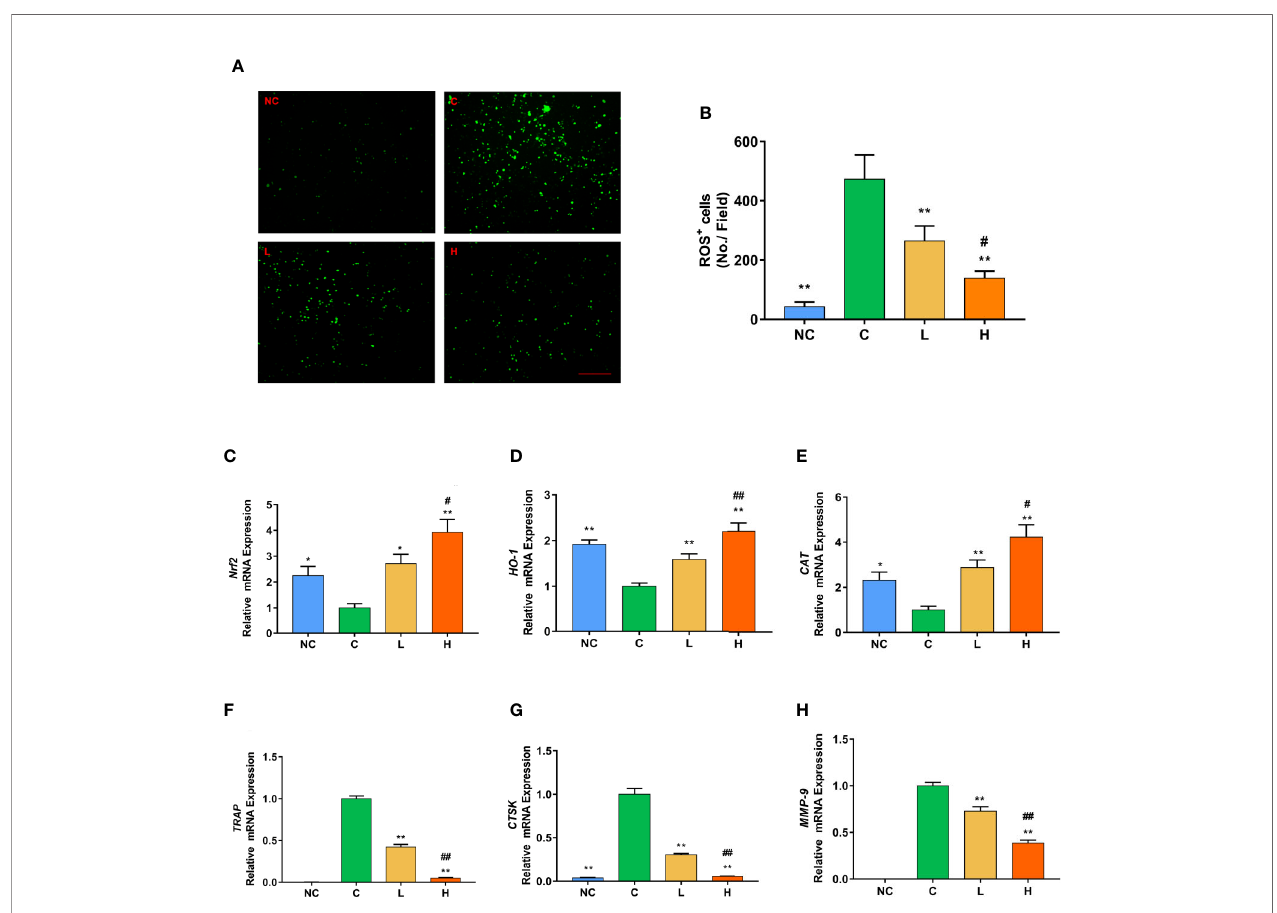
FIGURE 3 | TF3 attenuates RANKL-induced ROS generation in vitro . (A) Representative images of RANKL-induced ROS generation detected by DCFH-DA in BMMs with different concentrations of TF3. (B) Quanti fi cation of the number of ROS-positive cells per fi eld. (C-E) RT-qPCR analysis showed the expression levels of antioxidant genes in BMMs. (F – H) The mRNA expression of osteoclast-speci fi c marker genes. n = 3, * P < 0.05, ** P < 0.01 compared with C group. # P < 0.05, ## P < 0.01 compared with L group. Scale bar = 100